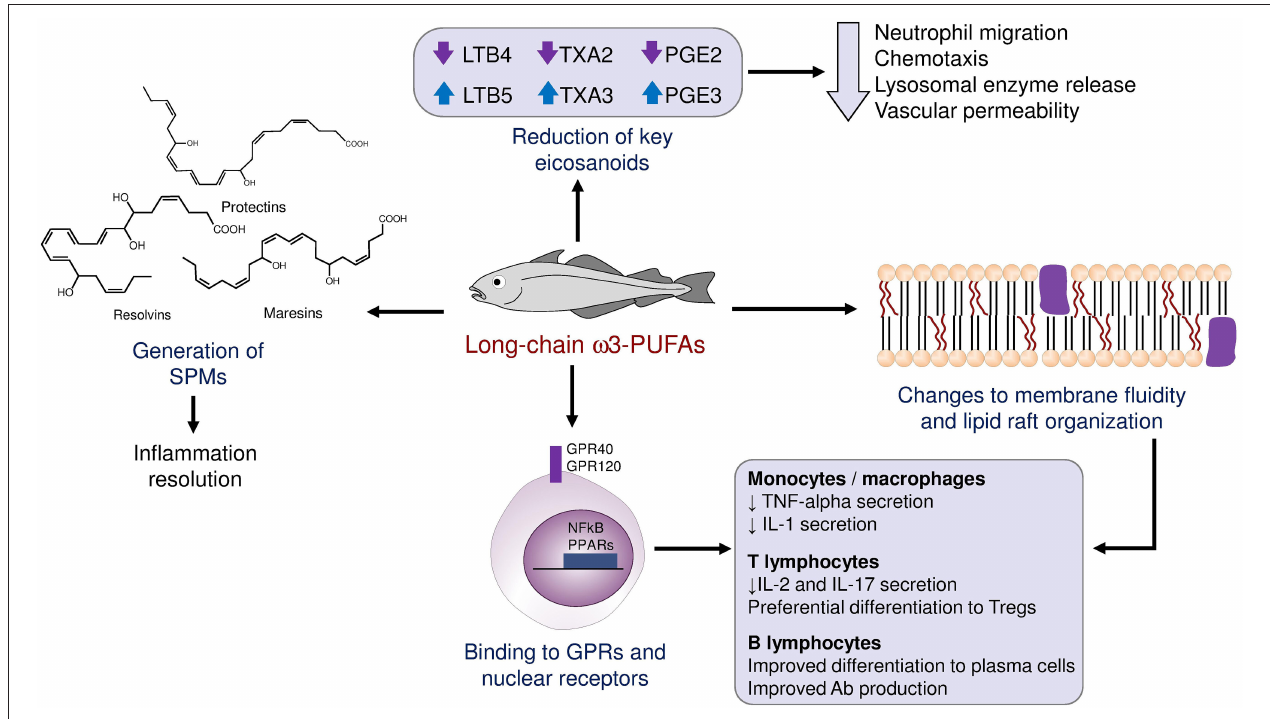
FIGURE 1 | Schematic summary of the mechanisms through which ω 3-PUFA influence the immune response and local inflammation. inflammation, and a significantly lower prevalence of